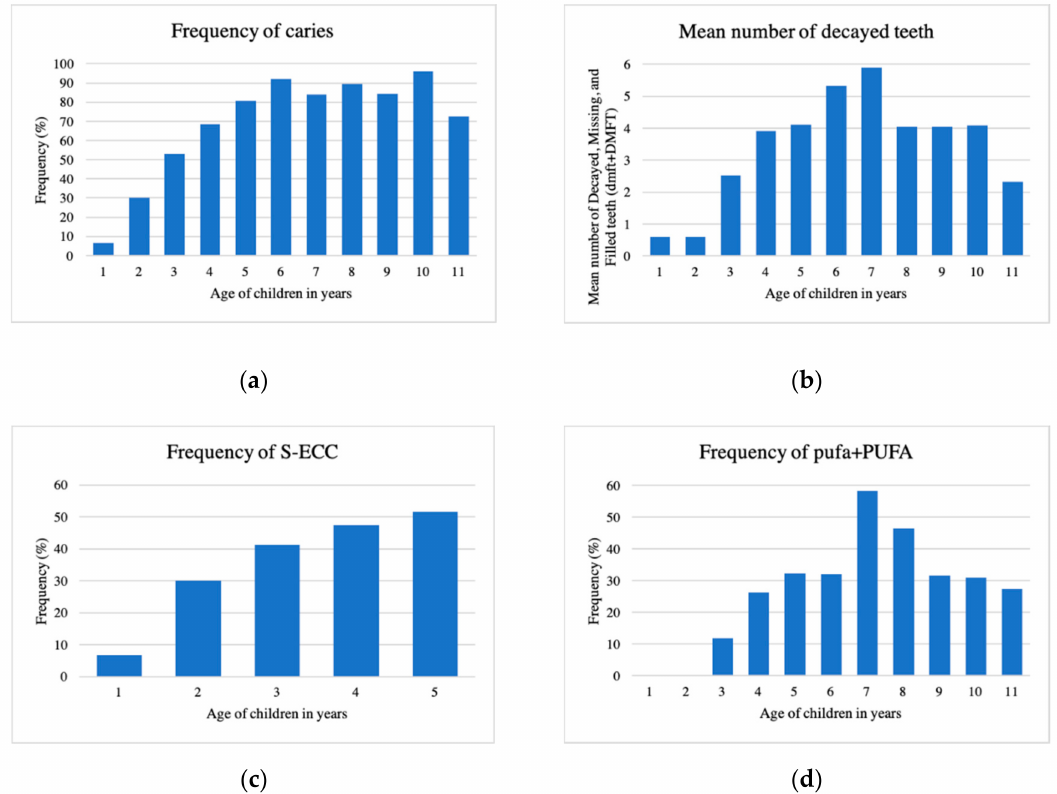
Figure 1. Caries experience by age. A combination of four graphs showing: ( a ) Frequency of caries; ( b ) Mean number of decayed teeth, defined as decayed, missing, or filled teeth (dmft + DMFT); ( c ) Frequency of severe early childhood caries (S-ECC, i.e., caries in children under age 6); ( d ) Frequency of pulpal involvement, ulceration, fistula, or abscess (pufa + PUFA) by